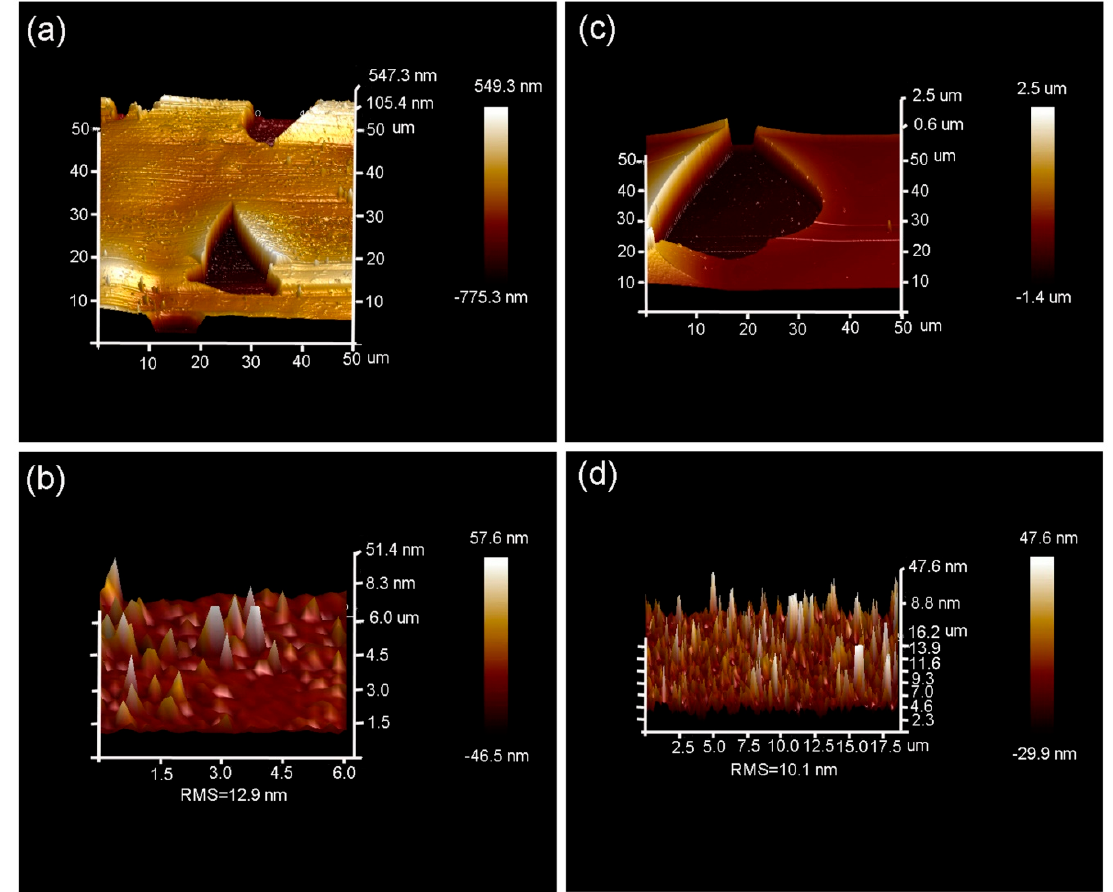
Figure 4. AFM images showing over-viewed surface morphology with a scanning zone of 50 × 50 μ m 2 of the 194 keV H 2+ -implanted 6H-SiC at 450 °C followed by 1100 °C annealing for 15 min ( a ), the 194 keV H 2+ -implanted 6H-SiC at 900 °C ( c ); ( b , d ) show the surface morphology of the exfoliation zone for the H 2+ -implanted 6H-SiC at 450 °C followed by 1100 °C annealing for 15 min and H 2+ -implanted 6H-SiC at 900 °C, respectively.